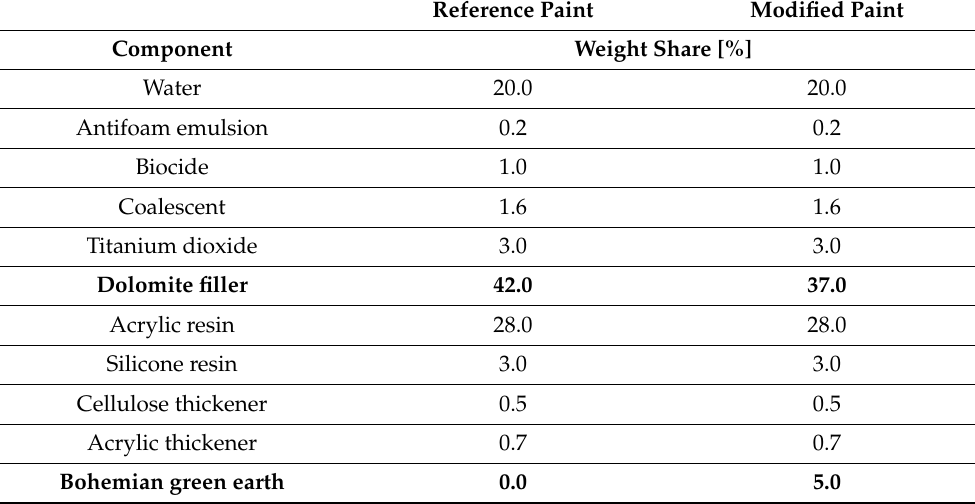
Table 3. Reference and modified paint formula.